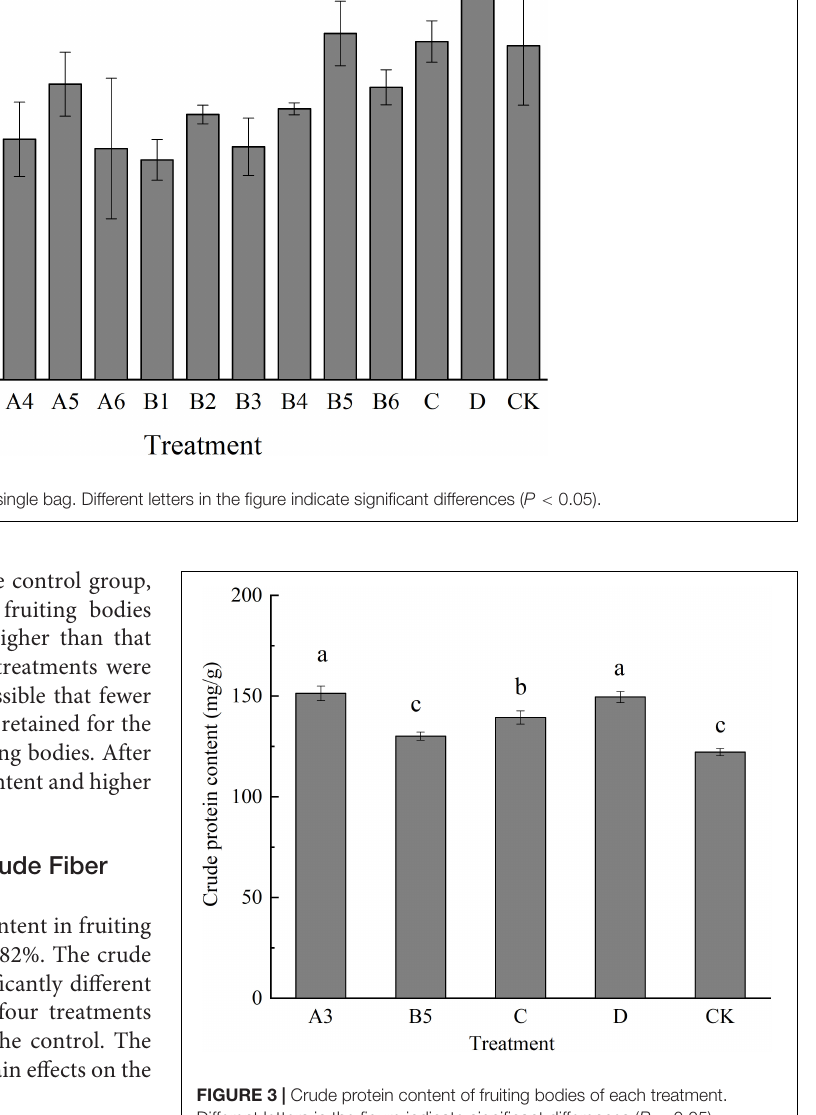
Effects of Different Treatments on the Total Sugar Content of Fruiting